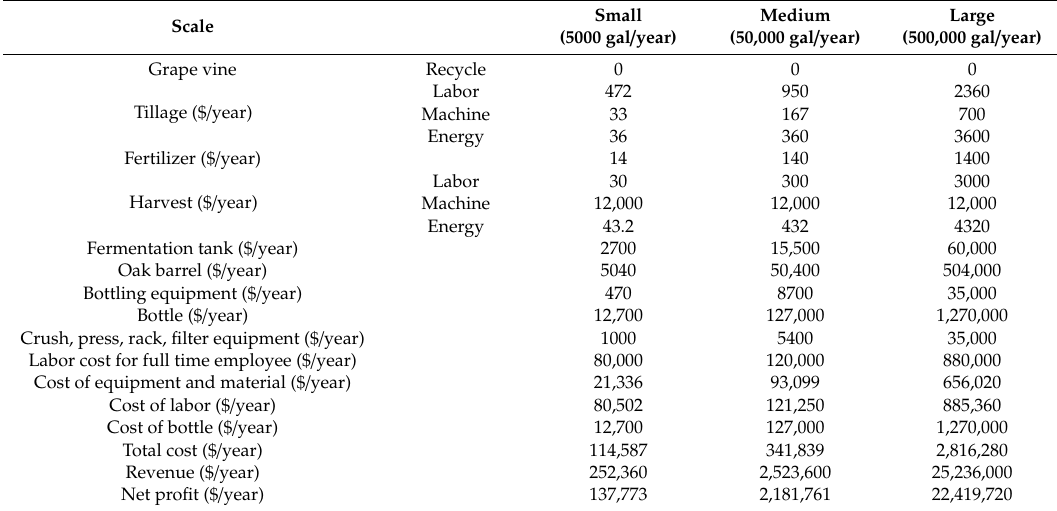
Table 5. Annual economic results from techno-economic analysis of various production scales.* .